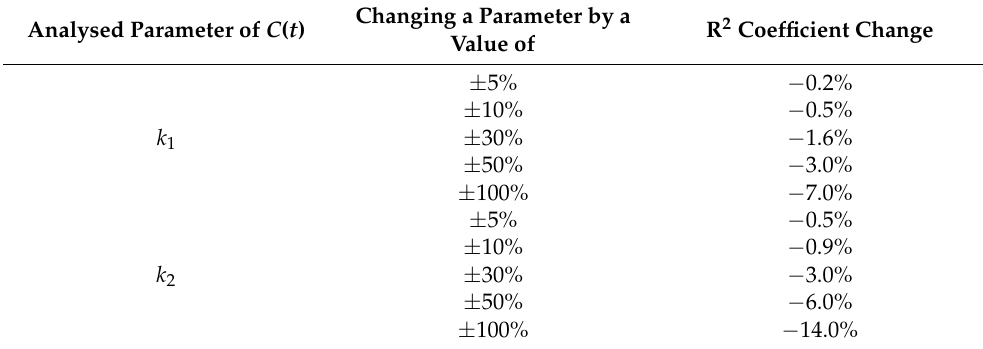
Table 12. Influence of changes in k 1 and k 2 parameters of model Equation (17) on the coefficient of fitting the model to experimental points.